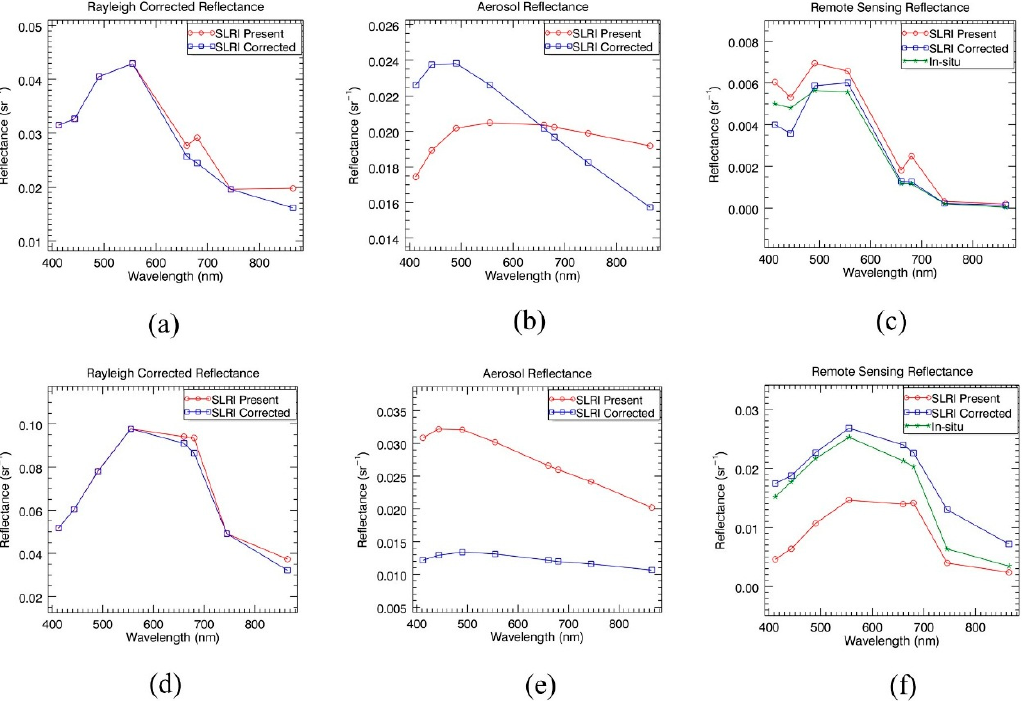
Table 2. Match-up validation results between in situ and GOCI data before and after the CIDUM correction for the six visible bands.